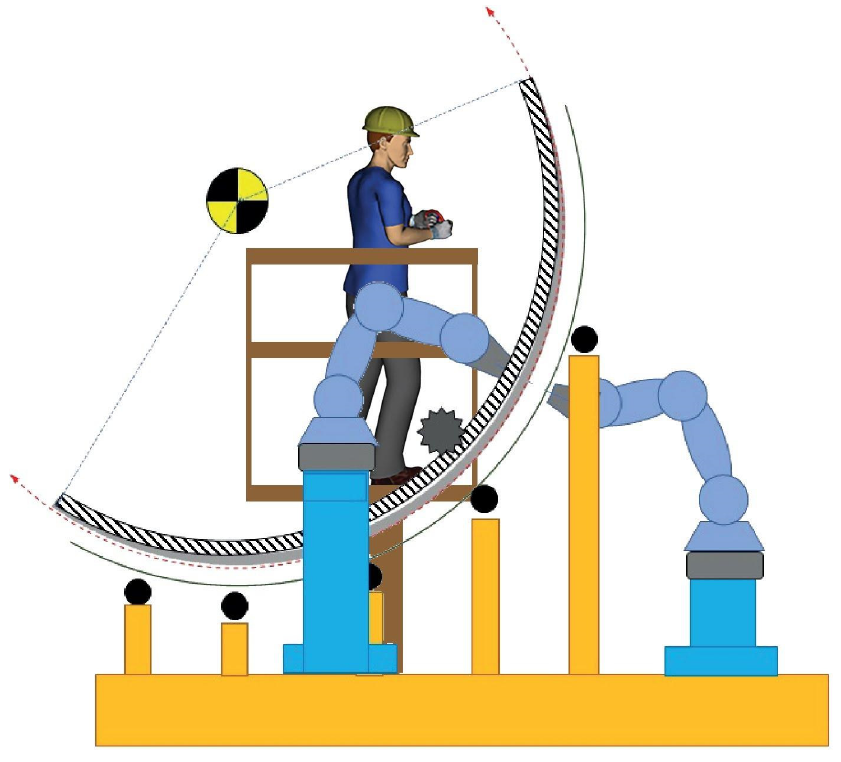
Figure 5. Workstation schematic layout.